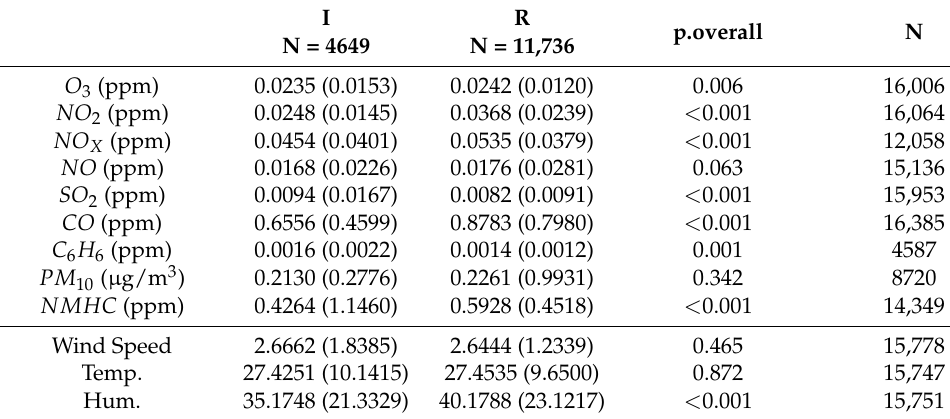
Table 2. Comparison between residential and industrial area.